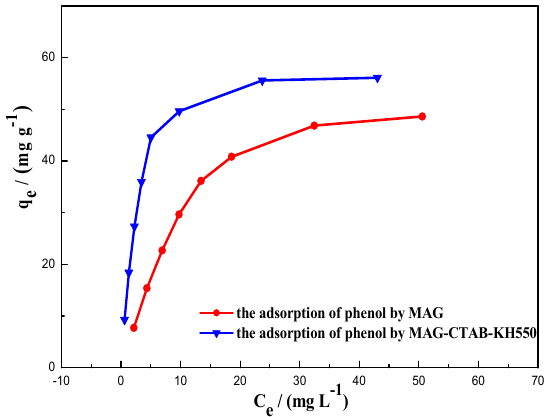
Figure 7. Equilibrium isotherms of adsorption of MAG, and MAG–CTAB–KH550 for phenol.